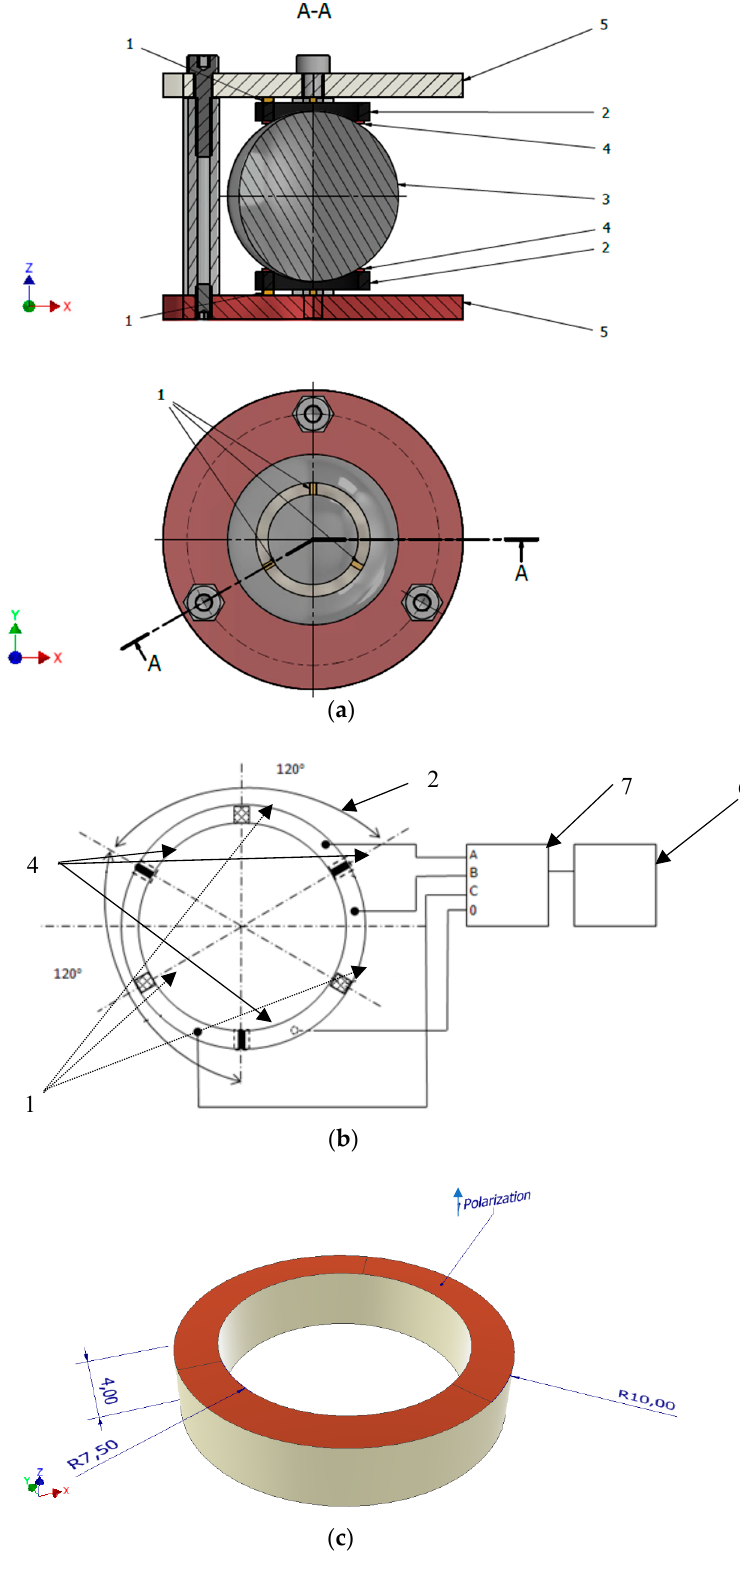
Figure 1. ( a ) 3DOF USM with the spherical rotor and two transducers: schematic view; ( b ) electrical layout and arrangement of electrodes of the ring type transducer; ( c ) Detailed view of piezoelectric transducer.